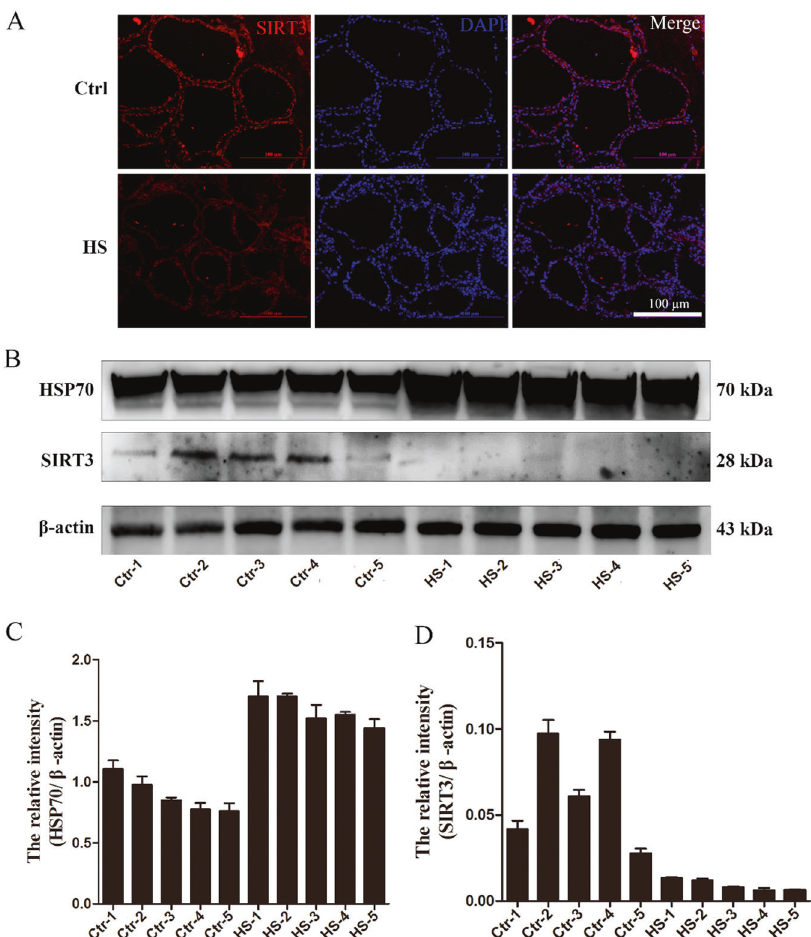
Fig. 1 Expression of HSP70 and SIRT3 in normal and heat-stressed cow tissues. A Immuno fl uorescence staining to observe the changes in the expression of SIRT3 in dairy cow mammary tissue, scale bar: 100 μ m. B Western blotting were performed to evaluate the protein expression of HSP70 and SIRT3 in the normal Holstein cattle and heat-stressed Holstein cattle. C , D ImageJ was used to quantify HSP70 and SIRT3 protein levels in the mammary tissues of normal Holstein cattle and heat-stressed Holstein cattle. Data are expressed as mean ±